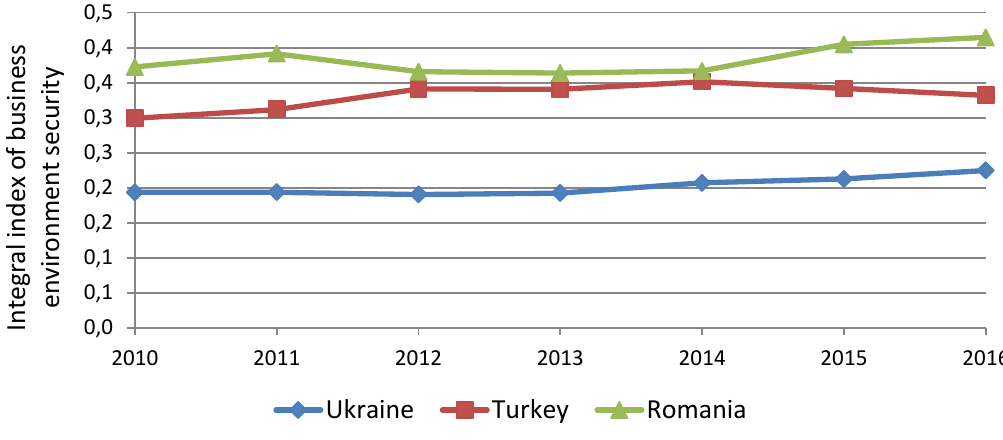
Figure 3. Dynamic of the integral indicator of business environment security in Ukraine and “countries-outsiders”